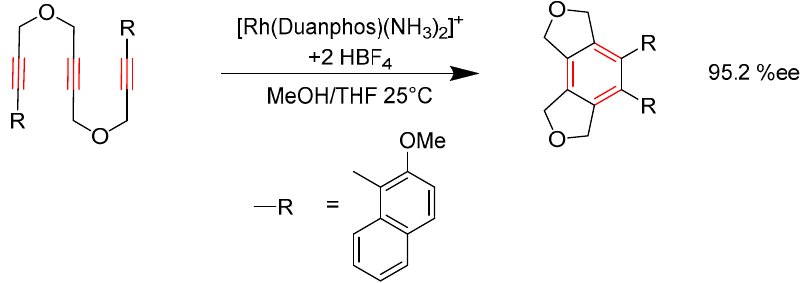
Figure 12. Molecular structure of the rhodium ammonia catalyst precursor [Rh(( S c, R p)- Duanphos)(NH 3 ) 2 ] + . Hydrogen atoms are omitted for clarity.